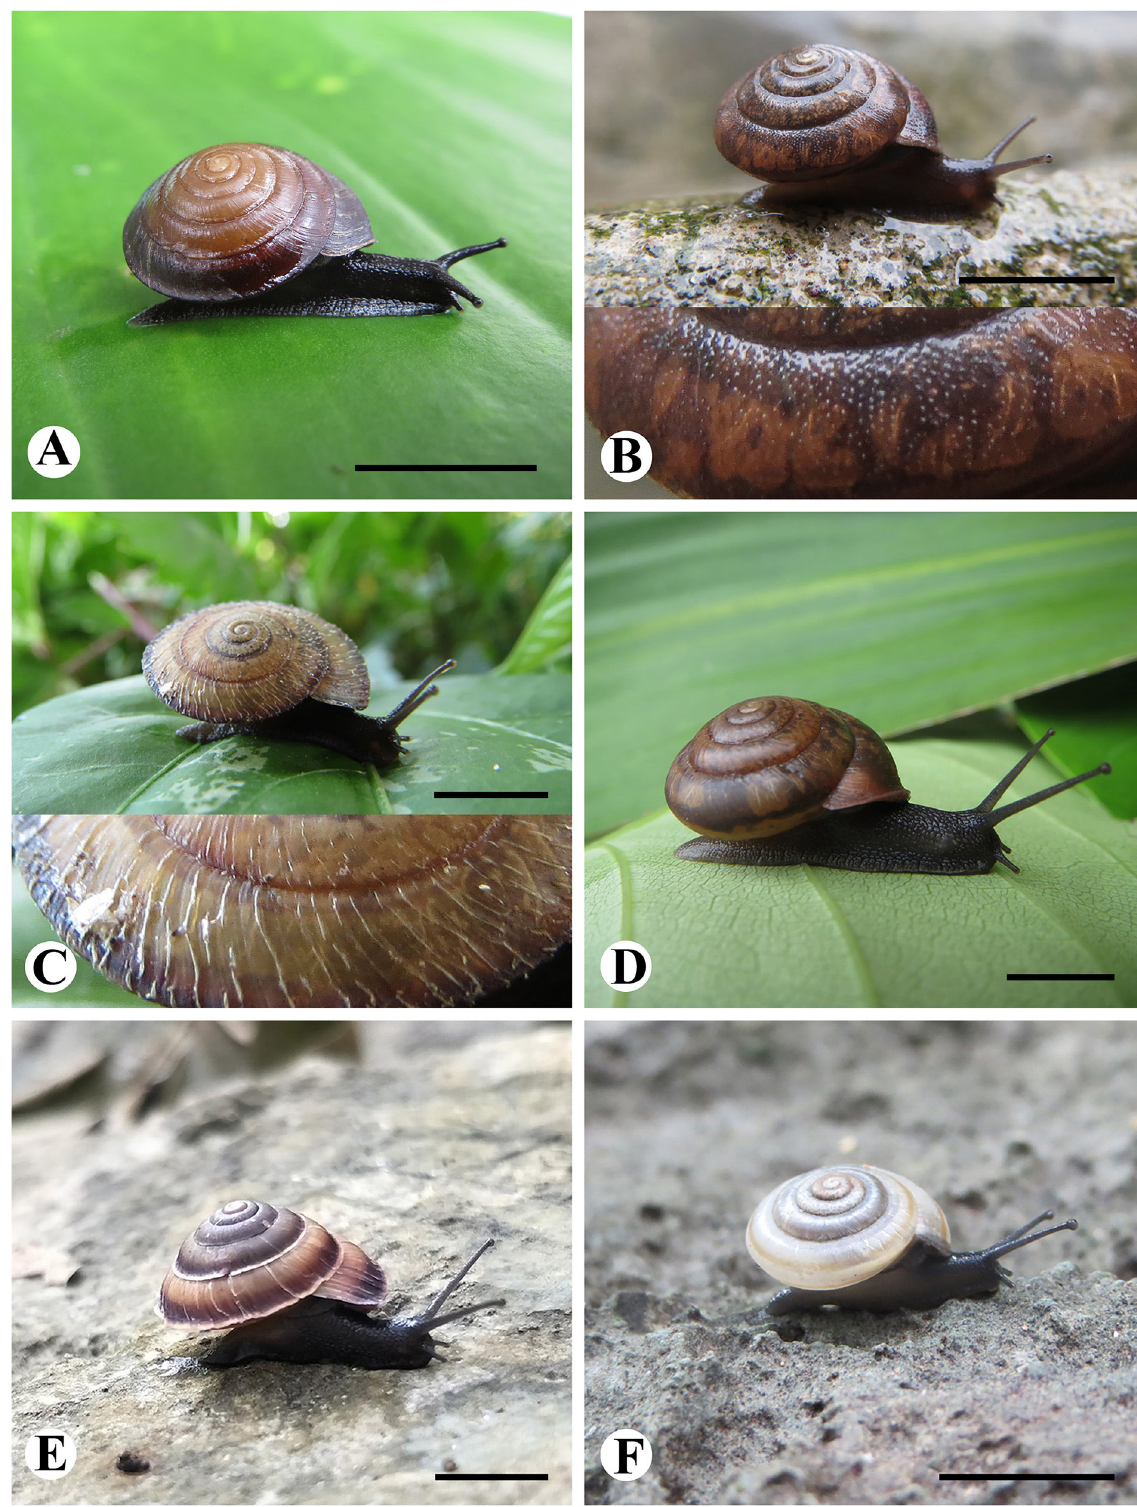
Fig. 4. Living adults of Landouria spp. from northeastern Thailand. A . Landouria circinata sp.